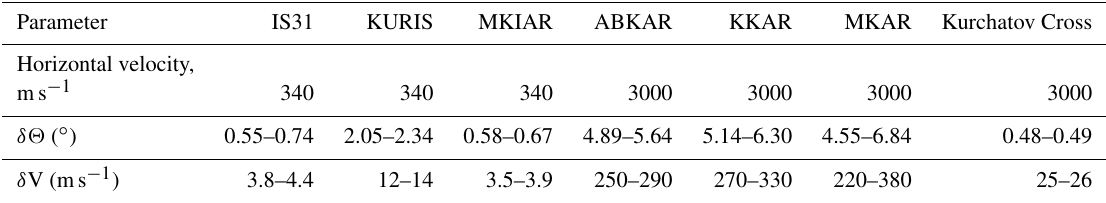
Table 1. Uncertainties of azimuth and apparent velocity estimates. Parameter IS31 KURIS MKIAR ABKAR KKAR MKAR Kurchatov Cross Horizontal velocity, ms − 1 340 340 340 3000 3000 3000 3000 δ(cid:50) ( ◦ ) 0.55–0.74